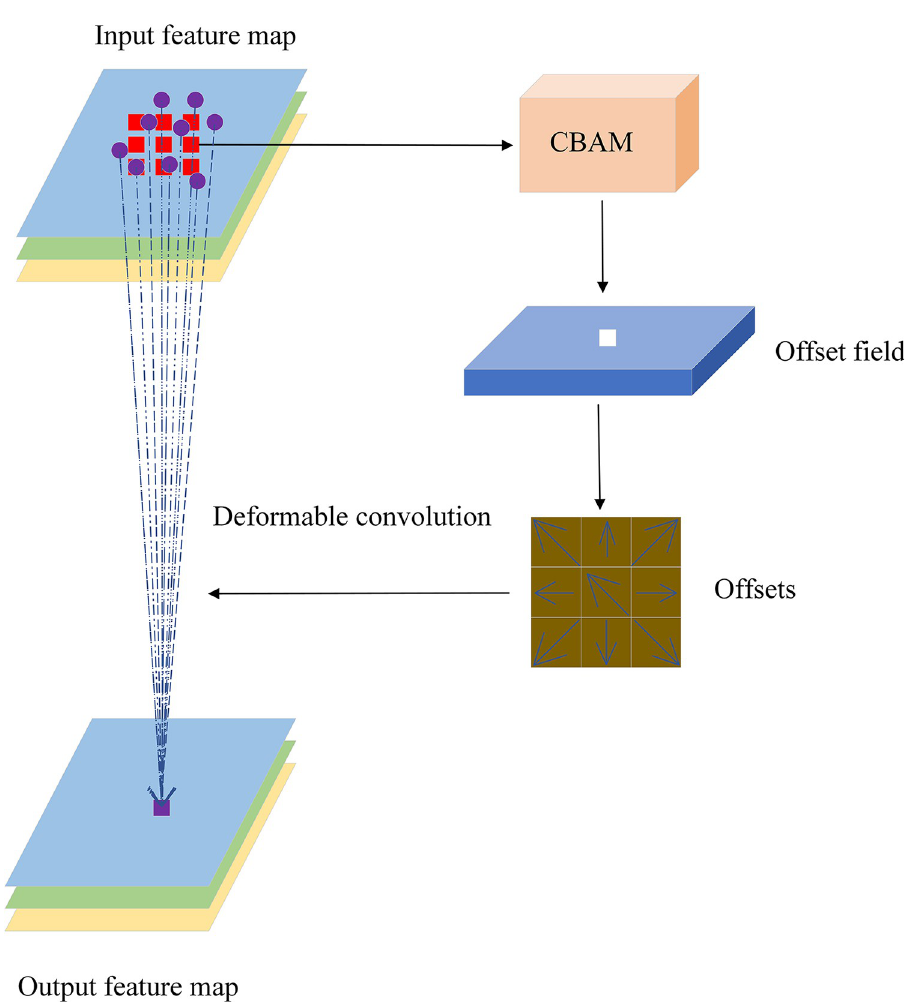
Fig 4. The deformable convolution module of the fusion convolution self-attention module. The left side is the feature extraction branch, and the right side is the offset learning branch. The offset is learned by the CBAM module.